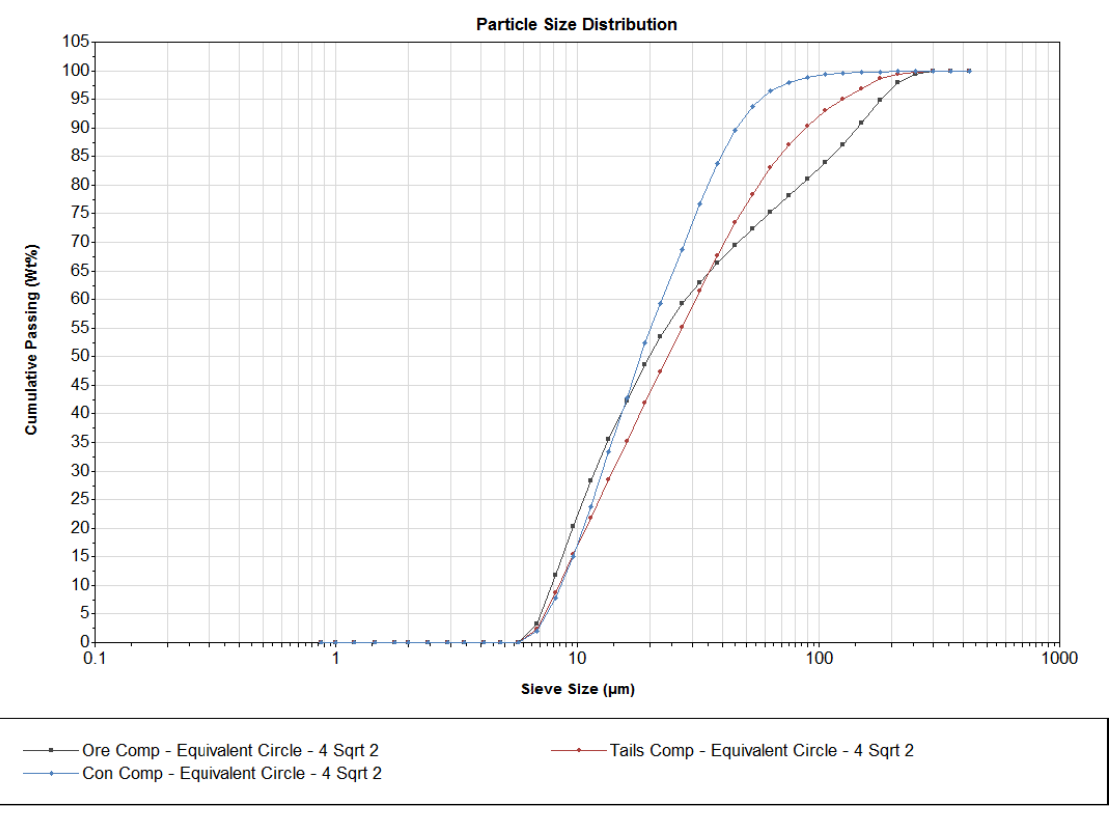
Figure 4. Particle size distributions of MPC (Mountain Pass cleaner flotation concentrate) and other Mountain Pass MLA (Mineral Liberation Analysis) materials.